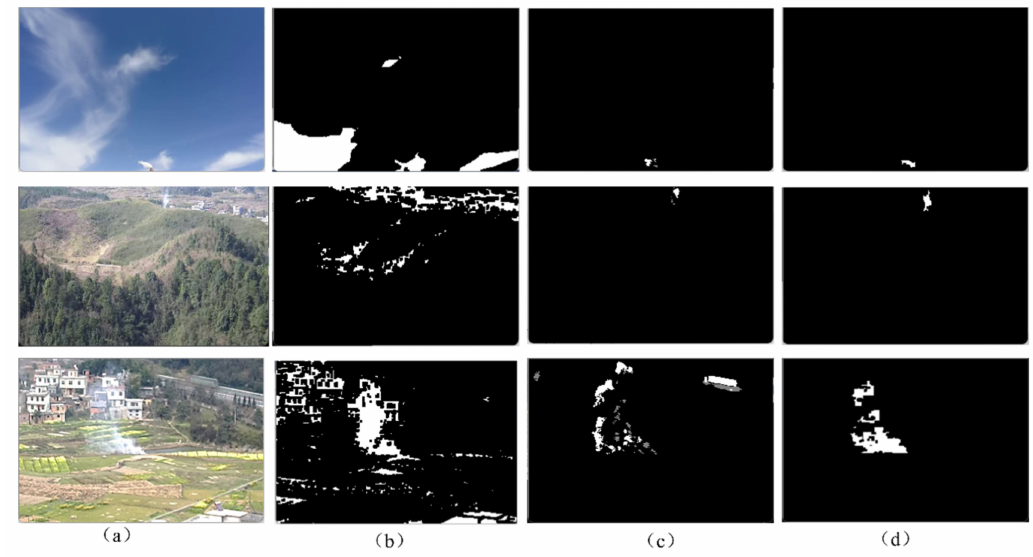
Figure 3. ( a ) Original image. ( b ) Dark channel image. ( c ) GMM image. ( d ) Fusion image.